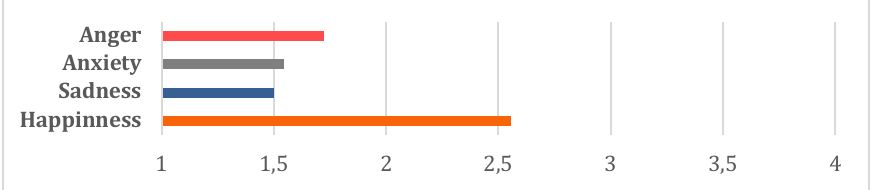
Fig. 8. Emotions when playing the game in academic secondary school